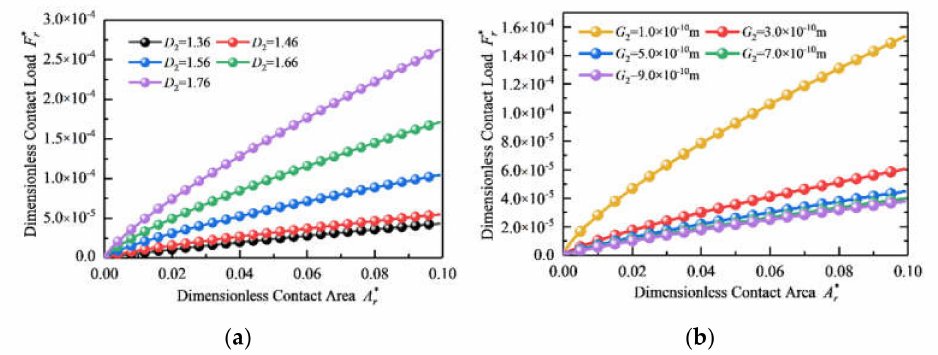
Figure 12. Variations in the dimensionless contact area A ∗ r with fractal dimension D : ( a ) different fractal dimensions D ; ( b ) different fractal roughness G